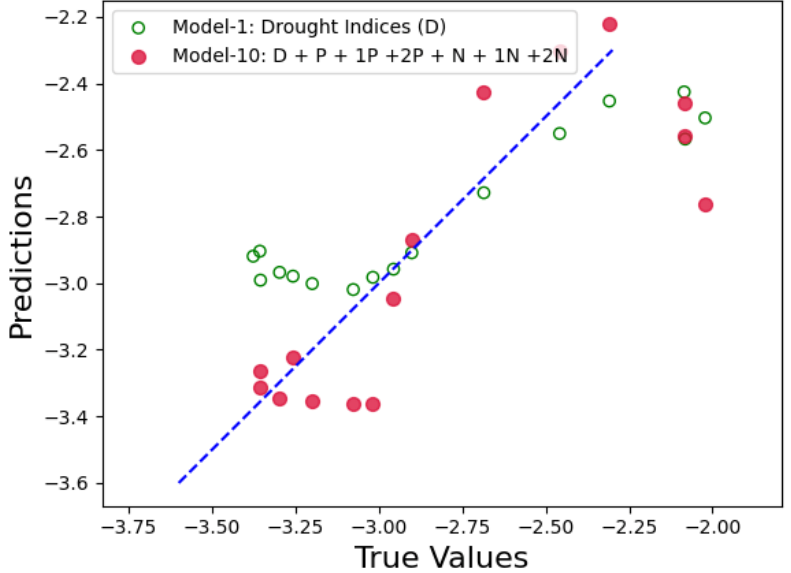
Figure 14. Result on unseen data during January-April 2021 using Generalized Linear Model and Model 10 from Table 3. The x-axis represents the true or the actual PDSI values and the y-axis represents the predicted PDSI values. The red circles are the predictions by Model 10 and the green hollow circles in the figures are the predictions by the control run model. The blue dashed line is the reference line to test the model performance.